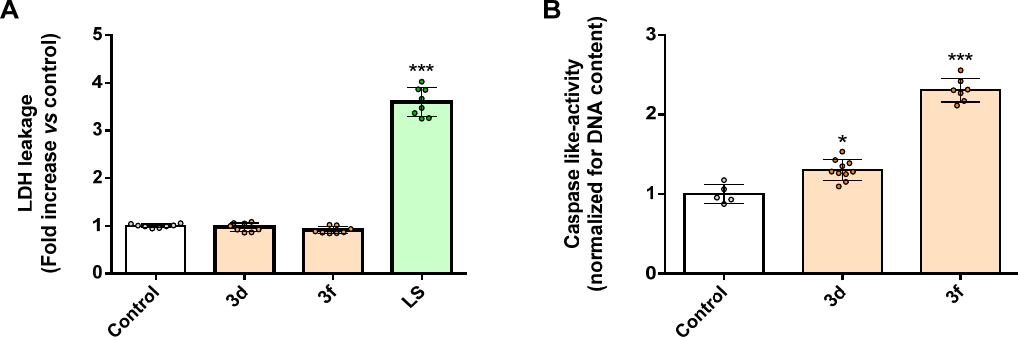
Figure 2. ( A ) LDH activity found in the culture media of the Sf9 cells treated with compounds 3d and 3f (100 µg/mL) for 24 h. Lysis solution (LS) was used as positive control to generate a maximum LDH release. ( B ) Caspase-like activity of the Sf9 cells after incubation with compounds 3d and 3f (100 µg/mL) for 24 h. Results are normalized for DNA content. * p < 0.05, *** p < 0.001.